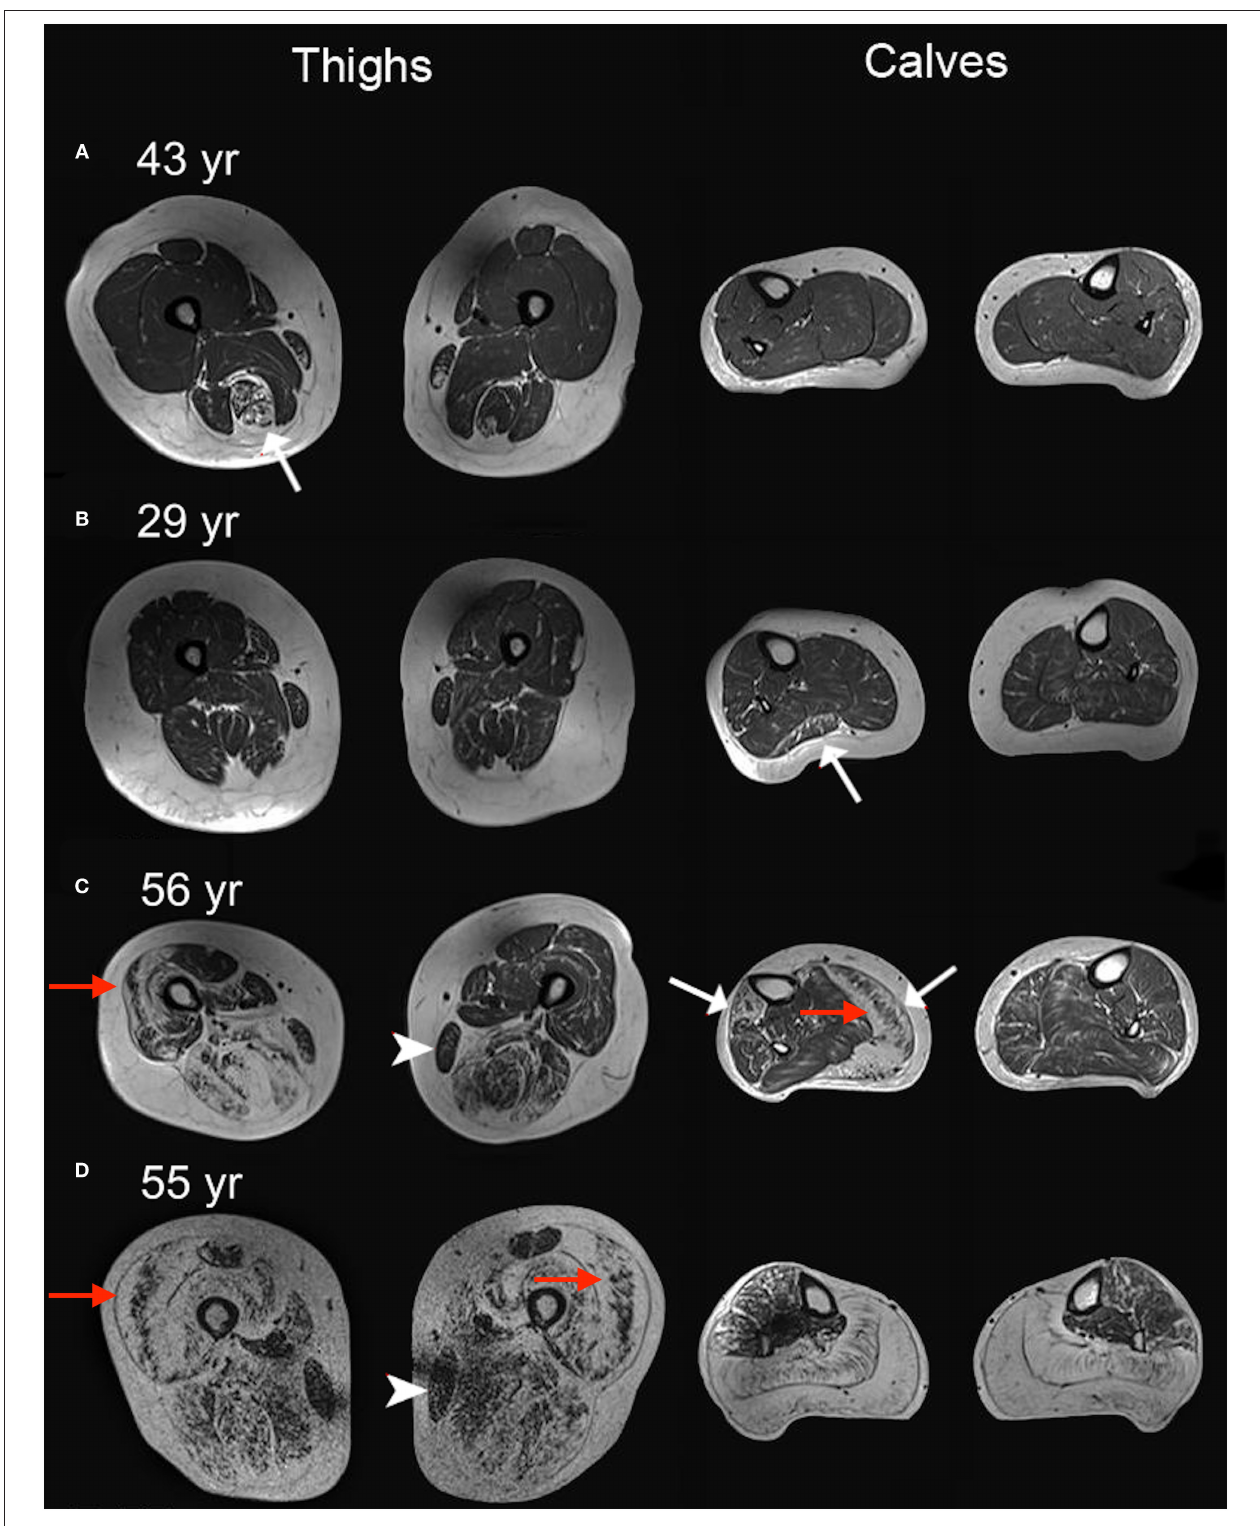
FIGURE 6 | Four T1-weighted examples. T1-weighted MRI images of thighs and calves of four women heterozygote for pathogenic DMD variants. White represents fat tissue. (A–D) shows a range of muscle affection from mild to severe. Cases (C,D) are particularly affected with prominent replacement of muscle by fat.